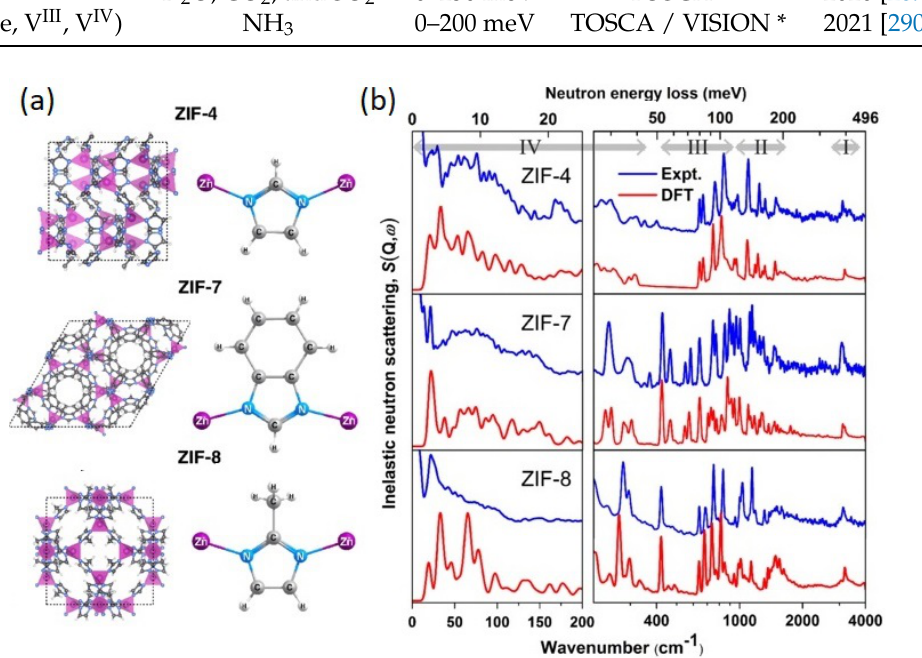
Figure 9. ( a ) Nanoporous hybrid framework structures of ZIF-4, ZIF-7, and ZIF-8. The inorganic building blocks are represented by purple ZnN 4 tetrahedra. ( b ) Experimental (TOSCA T = 10 K) and theoretical (DFT; CRYSTAL14) INS spectra for these compounds. Adapted from Ref. [264] with permission from APS (https://doi.org/10.1103/PhysRevLett.113.215502) (accessed on 28 April